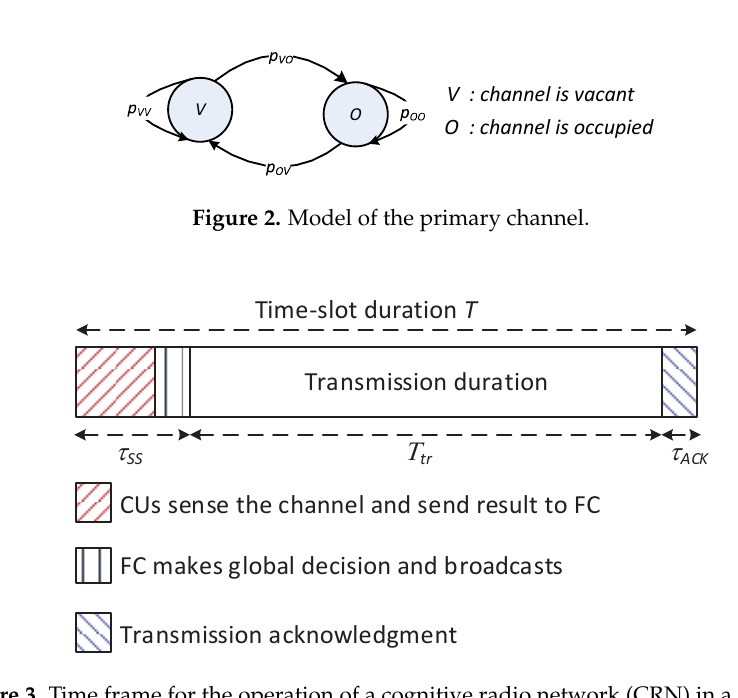
Figure 3. Time frame for the operation of a cognitive radio network (CRN) in a time